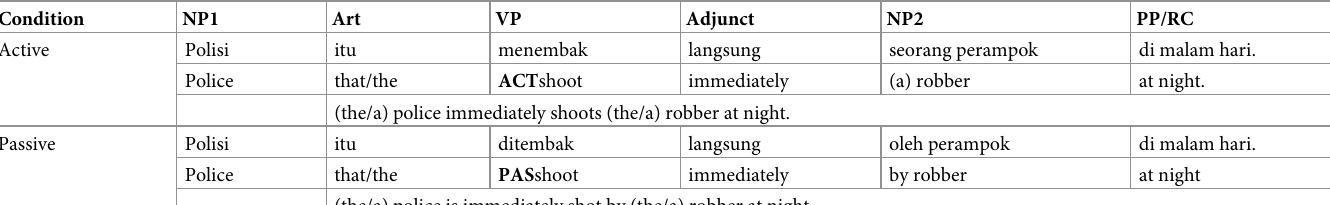
Table 2. Stimuli examples of each condition. Condition